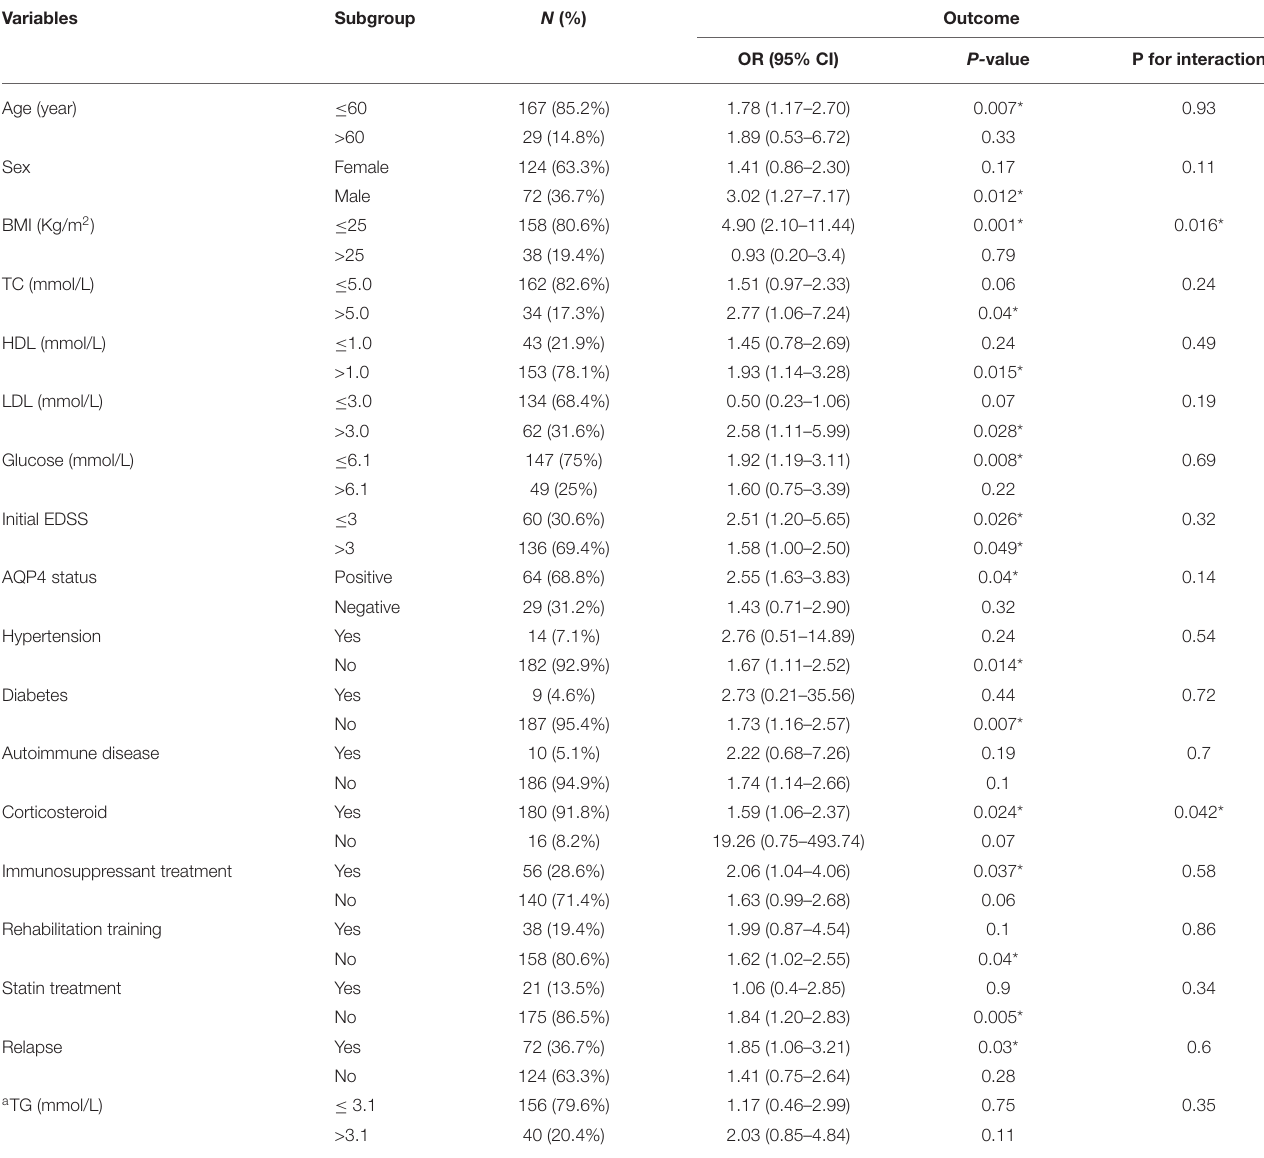
TABLE 3 | Association between TG and the outcomes according to baseline characteristics.